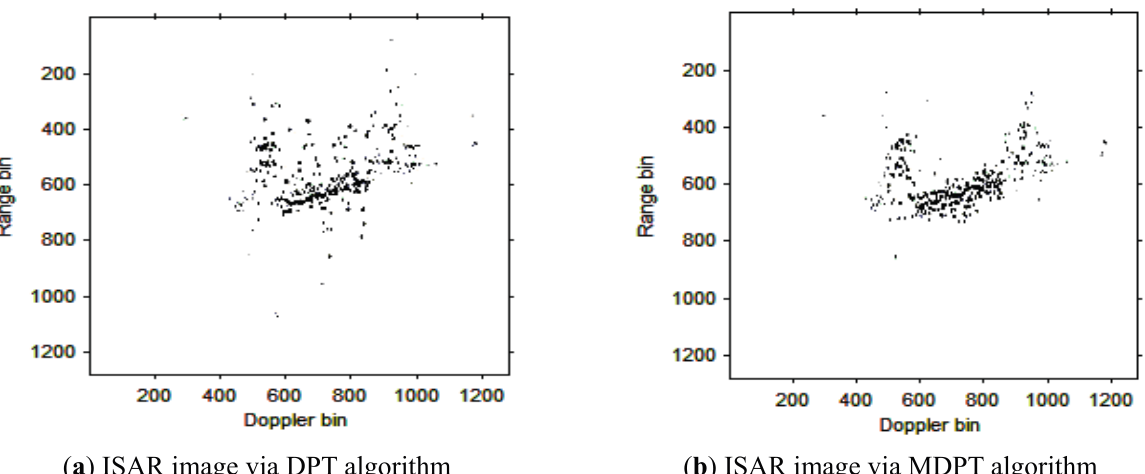
Figure 15. ISAR images at time t = 0.48 s based on DPT and MDPT algorithms.